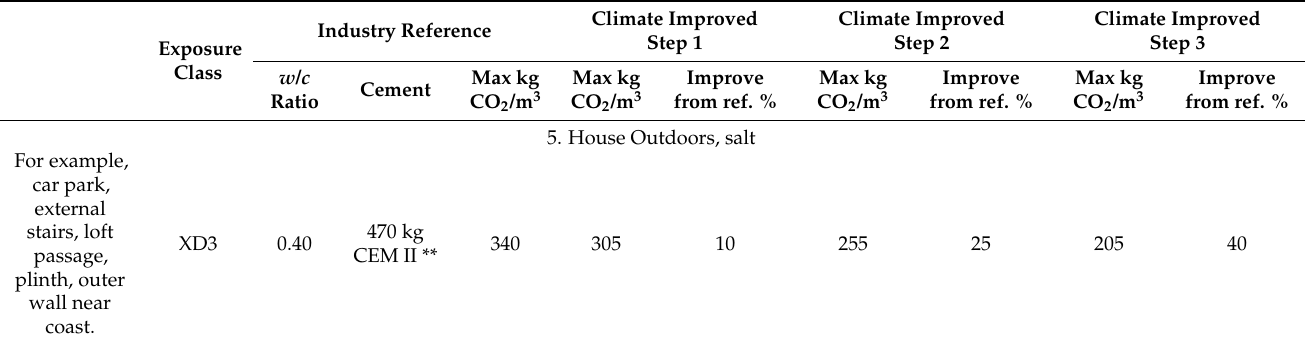
Table 6. Swedish concrete industry reference [10].